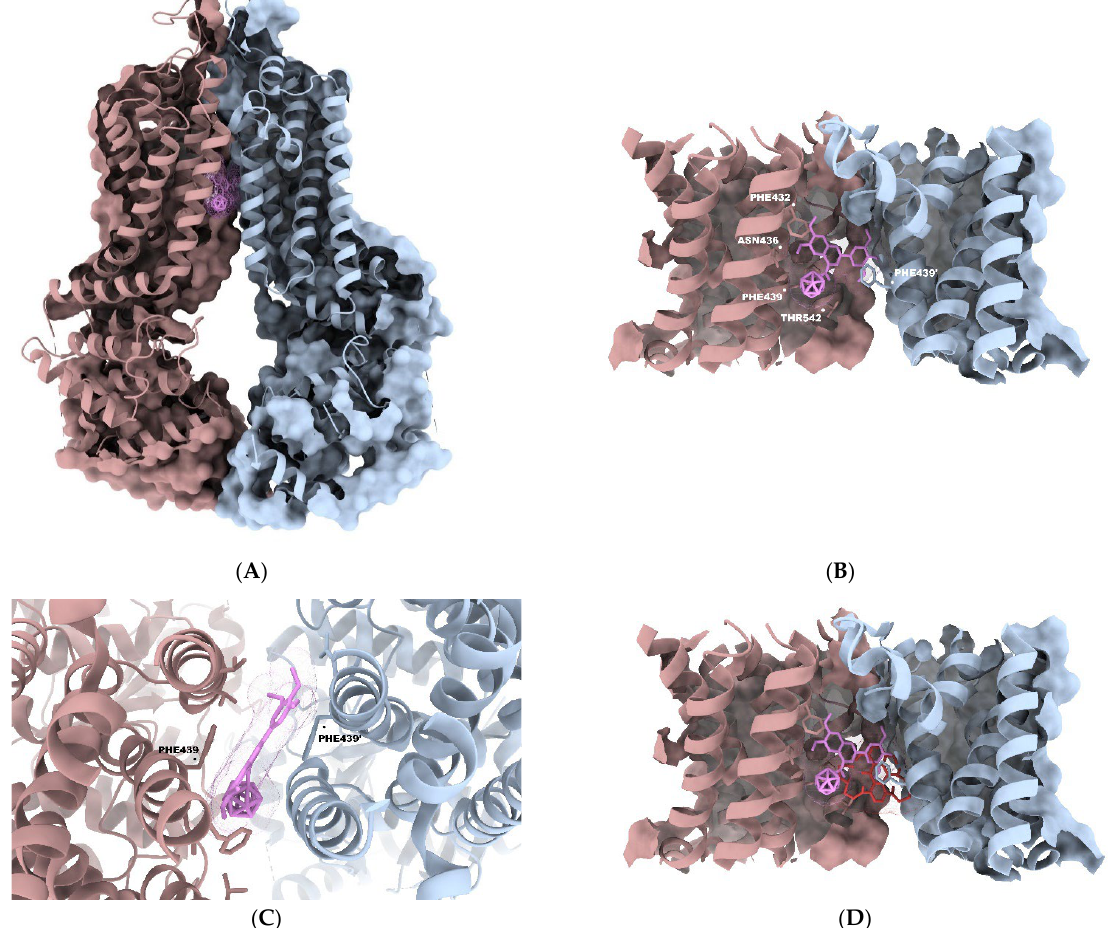
Figure 4. ( A ) Cartoon representation of ABCG2. Monomers are depicted in pink and blue. DMQCd bound to inner inhibitor-binding cavity (referred to as cavity S1) [26]. ( B ) Top-ranked pose of DMQCd docked into the ABCG2 cryo-EM structure (PDB code 5NJ3); DMQCd shown as stick model; hydrogen atoms omitted for clarity; binding free energy: −8.1 kcal/mol. ( C ) Docking of DMQCd into the crystal structure of ABCG2 (5NJ3); top-view, showing the sandwich-like binding mode between the Phe-439 residues of the protein. ( D ) Putative binding modes of top-ranked poses of DMQCd (pink) and MXN (red).